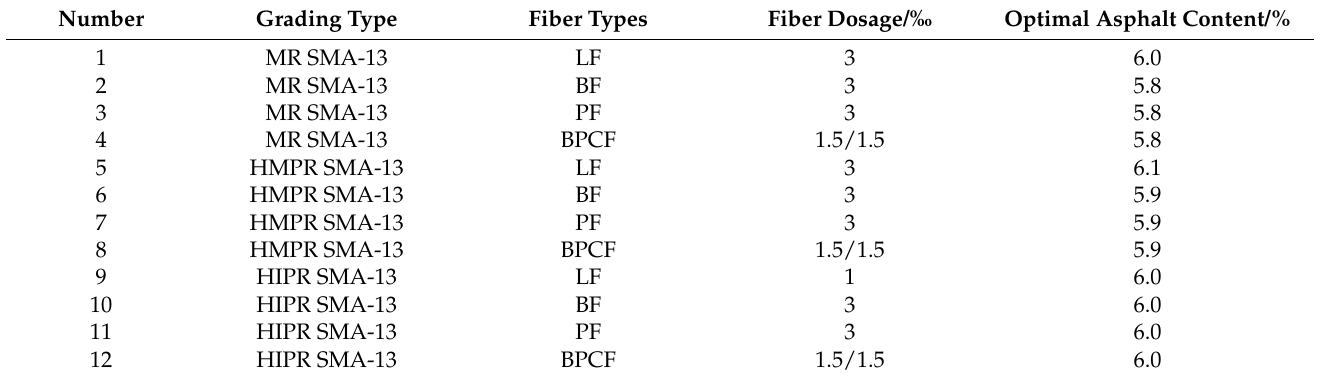
Table 8. Fiber dosage and asphalt content under three maintenance processes.